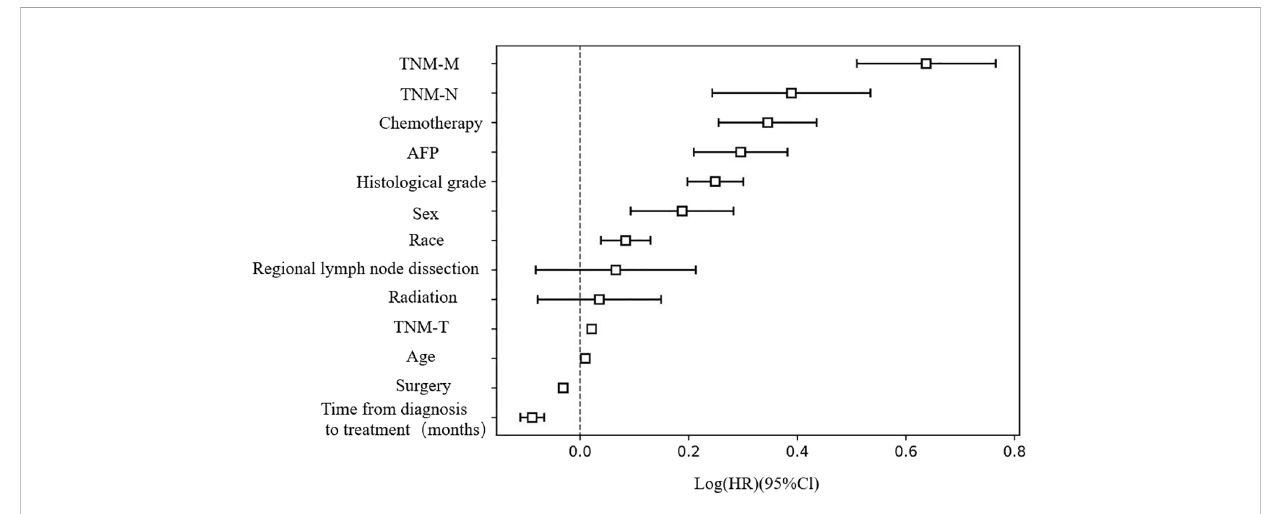
FIGURE 1 Risk factors assessment for HCC